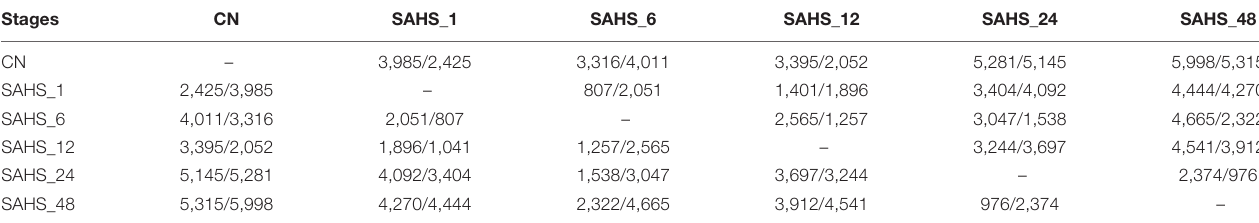
TABLE 4 | Numbers of DEGs involved in SAHS treatment stage transitions.